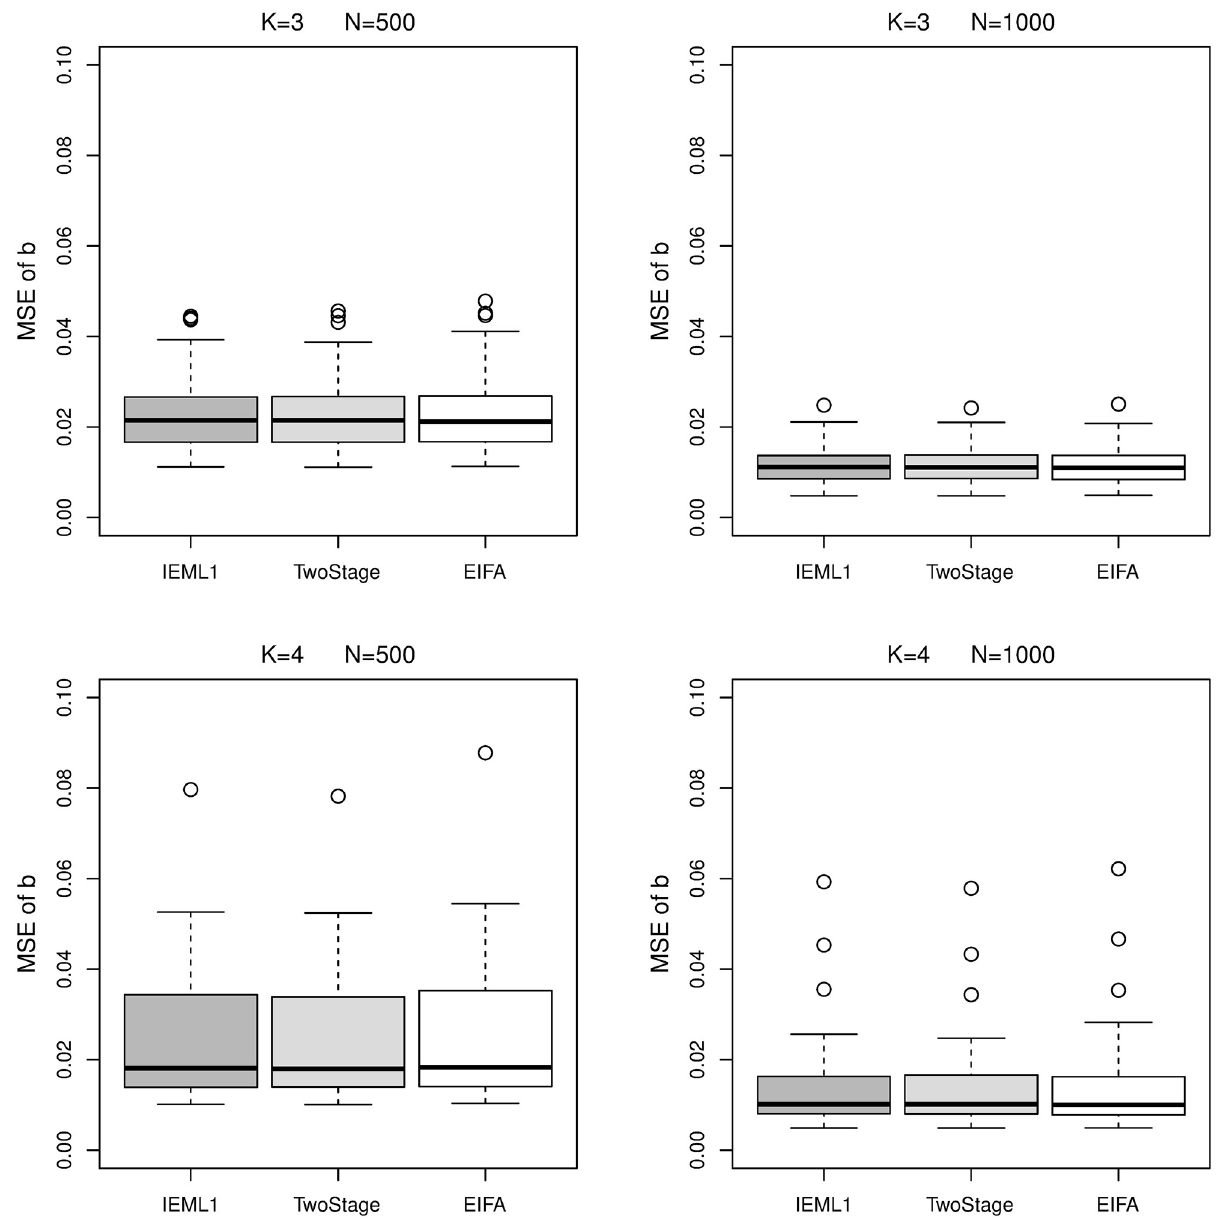
Fig 5. Boxplots of the MSE of b obtainedby IEML1 (dark gray boxes), two-stage (light gray boxes), EIFAthr and EIFAopt (white boxes) for K = 3 and 4 under sample size N = 500 and 1000.